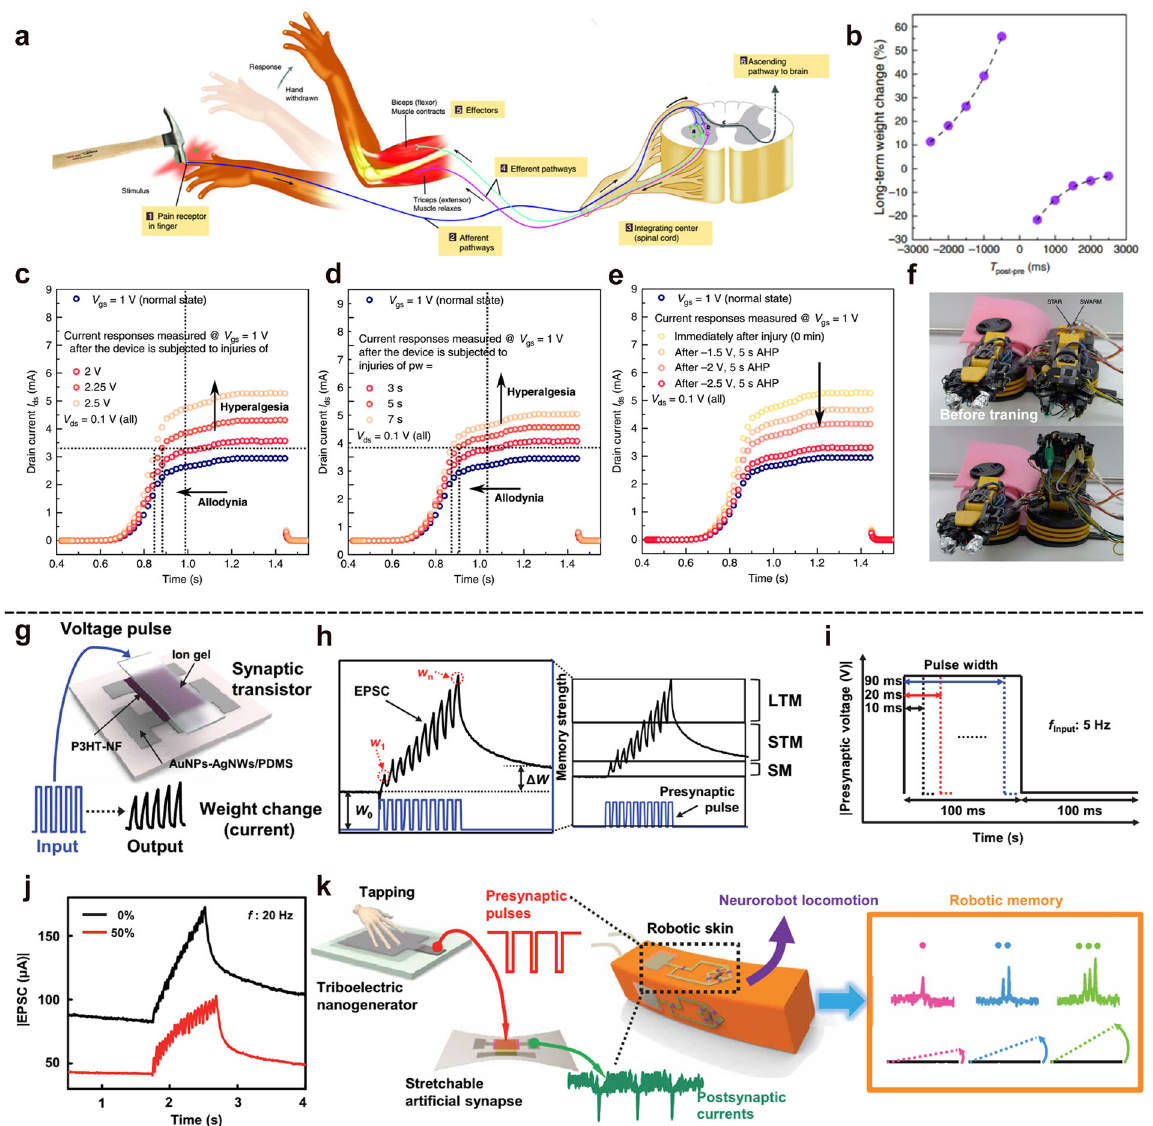
Fig. 8 The function of arti fi cial synapse realized by IGT. a The working principle of biological nociceptors and their central nervous control. Reproduced with permission 25 . Copyright 2020, Springer Nature. b The weight change in SWARM follows the anti-Hebbian rule. c – e The low- amplitude voltage V gs = 1 V indicates the normal state, and the high-amplitude voltage indicates damage and can cause sensitive reactions. f Sensorimotor platform capable of detecting and associating noxious stimuli. g Scheme diagram of the all fl exible ionic-gel gated transistor. Reproduced with permission 26 . Copyright 2019, Elsevier. h Scheme of the SM, STM, and LTM. I Schematic diagram of pulse width adjustment at 5 Hz. j Measured EPSCs of IGTs in response to presynaptic pulses at 20 Hz, under the strain with 0% and 50%. k Schematic illustration of